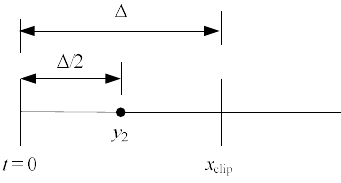
Figure 1. Illustration of binary quantizer type 1.